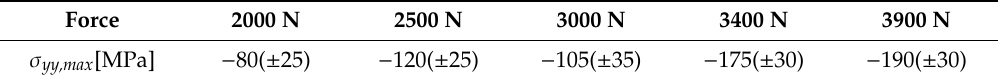
Table 3. Maximum values of the residual stress distribution σ yy ( y , z ) after unloading.